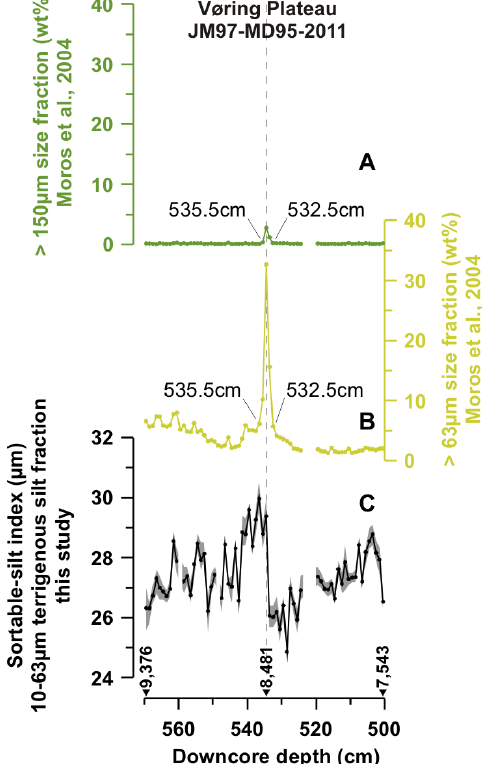
Figure 6. Changes in the coarseness of the sediments along the core as described by statistics based on the differential volume or weight distribution of grains within the samples. Variations in the dry-weight percent of (a) the >150µm size fraction and (b) the >63µm size fraction (M. Moros, personal communication, 2012). (c) Changes in the coarseness of the 10–63µm terrigenous silt frac- tion as suggested by the sortable-silt index.